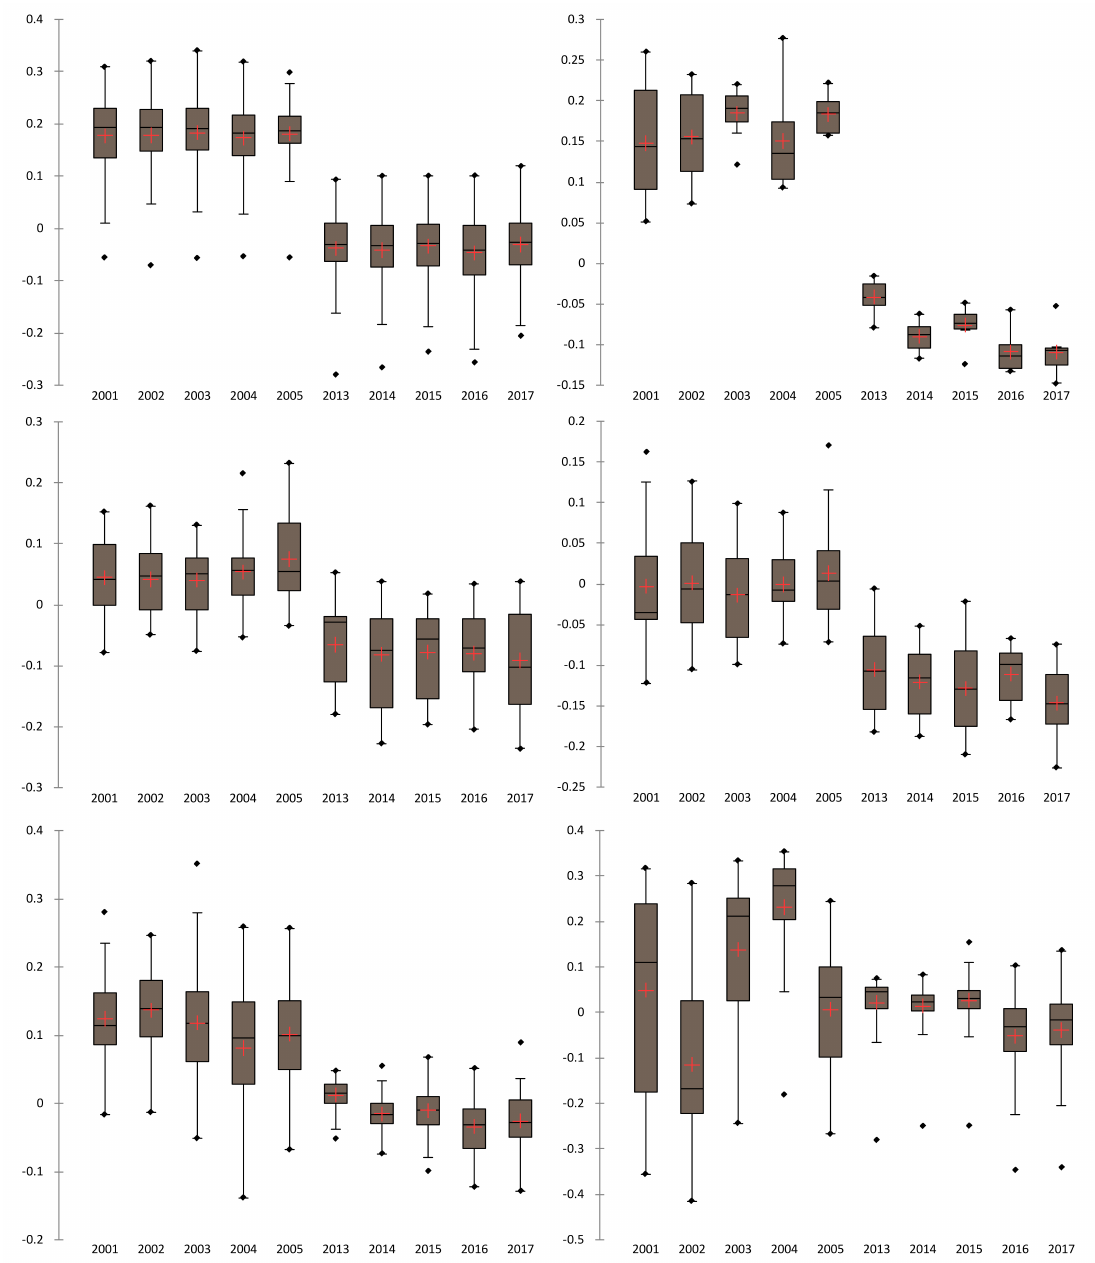
Figure 12. NDBI boxplots for the six sites: Confluence ( top-left ), Kaplan Park ( top-right ), dock ( middle-left ), Garibadi Street ( middle-right ), Museum ( bottom-left ), and Groupama Stadium ( bottom-right ); red cross: average; black dots: min and max